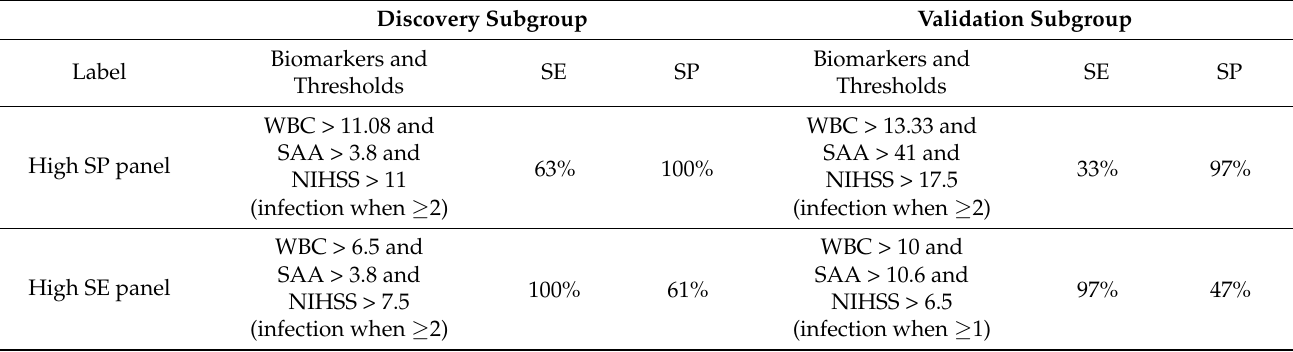
Table 7. Performance, Biomarkers and Thresholds for the PanelomiX